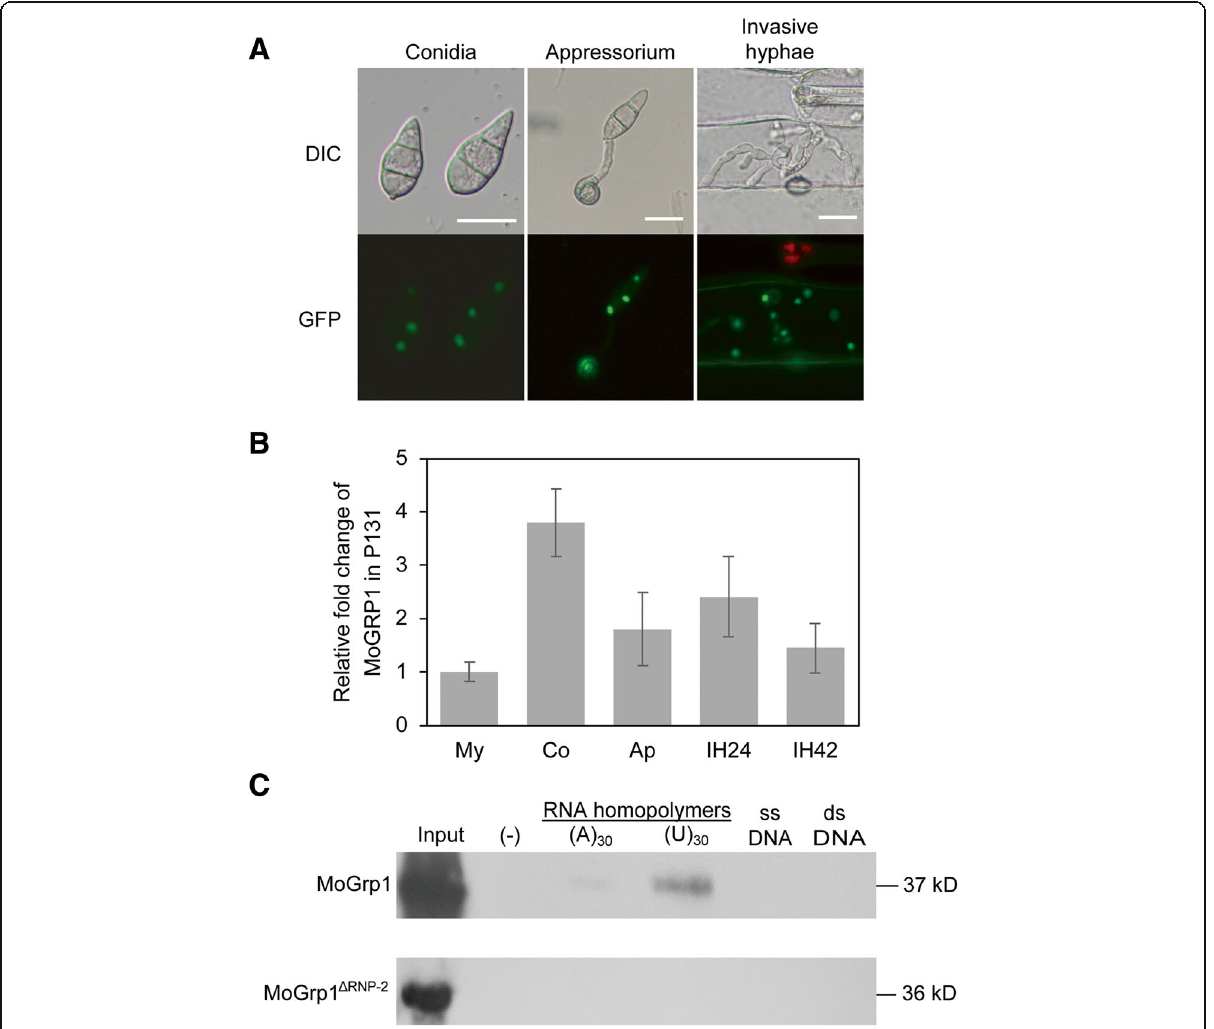
Fig. 4 MoGrp1 is localized to nuclei and binds to poly(U) RNA. a MoGrp1 is localized to nuclei of conidia, appressoria, and infection hyphae of strain cg1g expressing a MoGrp1-GFP fusion protein. Bar, 20 μ m; b Relative expression levels of MoGRP1 in mycelia (My), conidium (Co), mature appressorium (Ap12h), and invasive hyphae (IH24h and IH42h) measured by quantitative RT-PCR. The expression level of MoGRP1 was first normalized with the actin gene in each tested tissue, and the expression level of MoGRP1 was set to 1. The means and standard deviations were calculated based on two independent experiments with three replicates; c The 3 × Flag-MoGrp1 or 3 × Flag-MoGrp1 Δ RNP-2 constructs bind to different types of biotinylated nucleic acids, including poly(U) 30 , poly(A) 30 , single-strand DNA (ssDNA), and double-strand DNA (dsDNA). The 3×Flag-tagged protein was immunoprecipitated from strain cg1f expressing the 3×Flag-MoGrp1 fusion protein or strain cg1fdR expressing the 3×Flag- MoGrp1 Δ RNP-2 fusion protein. ( − ) is a negative control, showing that beads cannot bind target proteins without biotinylated nucleic